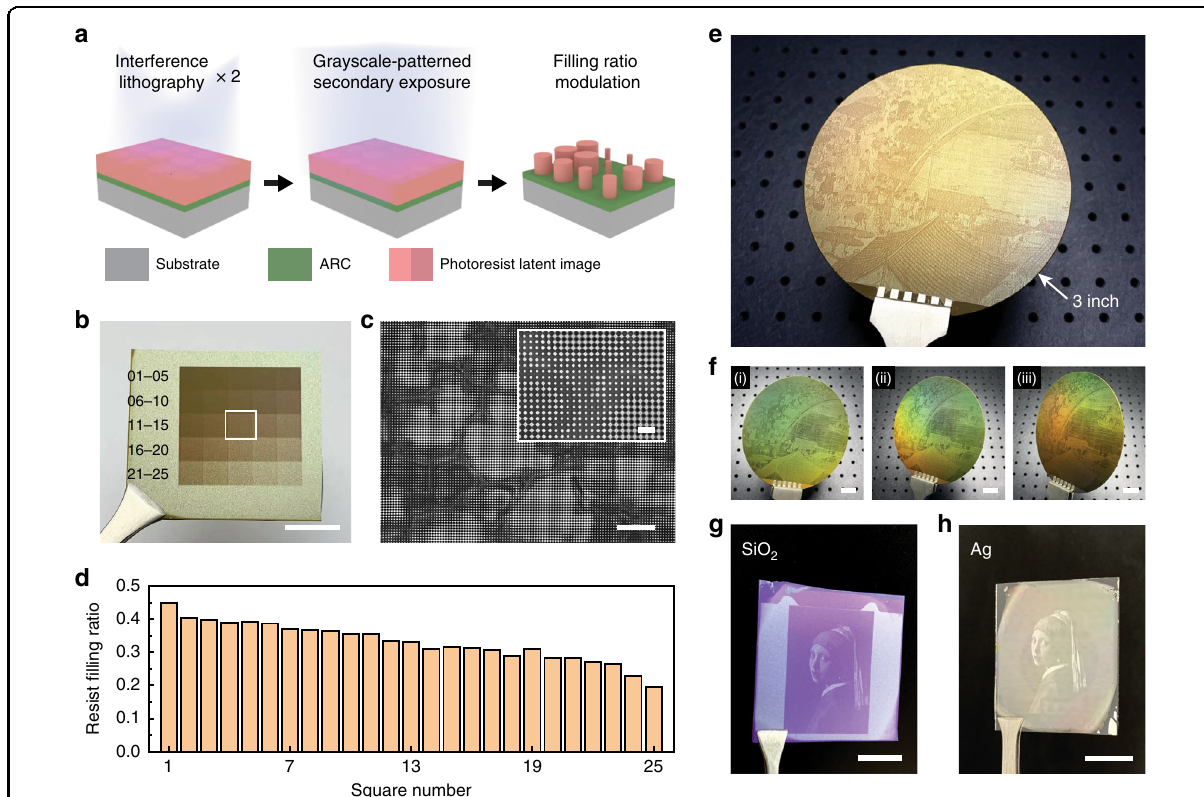
Fig. 5 Large-area grayscale painting using IL-GPSE. a Schematic of spatial modulation of fi lling ratio for 2D nanostructures using IL-GPSE. b The photograph of 25 squares of 700-nm-period 2D patterns on photoresist modulated by SE projection, showing a clear grayscale change from dark brown to light gold. c SEM images of the region labeled using white box in b . d Fraction area of photoresist calculated from SEM images of Fig. S15, showing a negative correlation between the photoresist fi lling ratio and the SE dose. e A photograph of the 3-inch grayscale painting of Along the River During the Qingming Festival in photoresist patterned by IL-GPSE. f A dynamic structural color due to the residual diffraction at tilting angles. Grayscale paintings patterned by IL-GPSE are further g etched into 300-nm-thick SiO 2 -coated Si wafer, or h deposited with 50-nm-thick Ag on glass. Scale bars, 2 µm (inset in c ), 10 µm ( c ), and 1 cm ( b , f – h